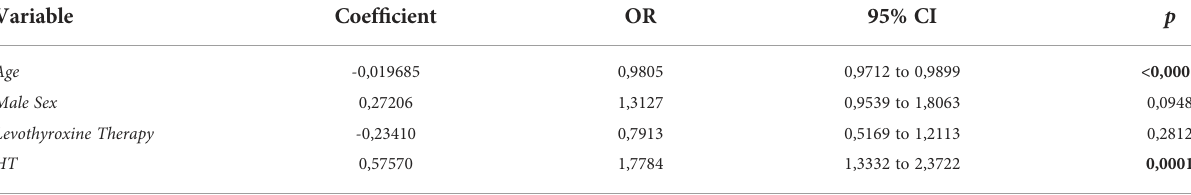
TABLE 2 Multivariable analysis between DTC and non-DTC